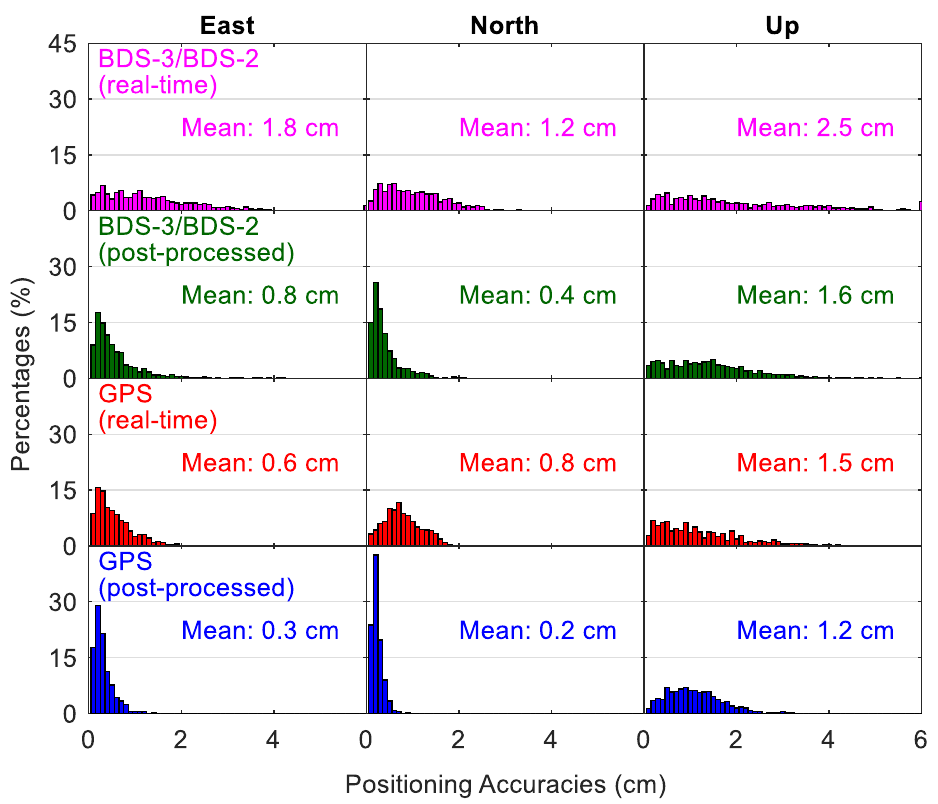
Figure 14. Figure 14. Distribution of positioning accuracies from different static precise point positioning (PPP) solutions.